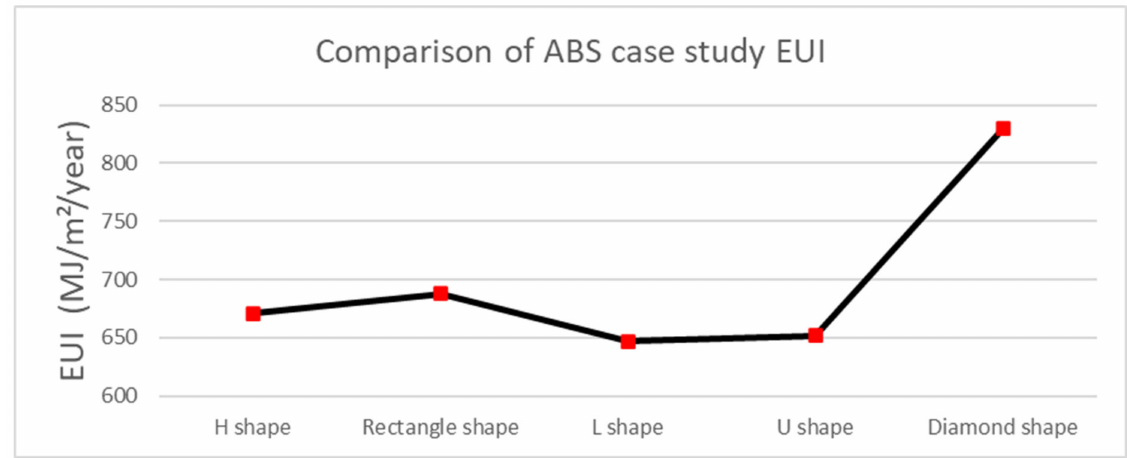
Figure 8. ABS Case study EUI comparison.